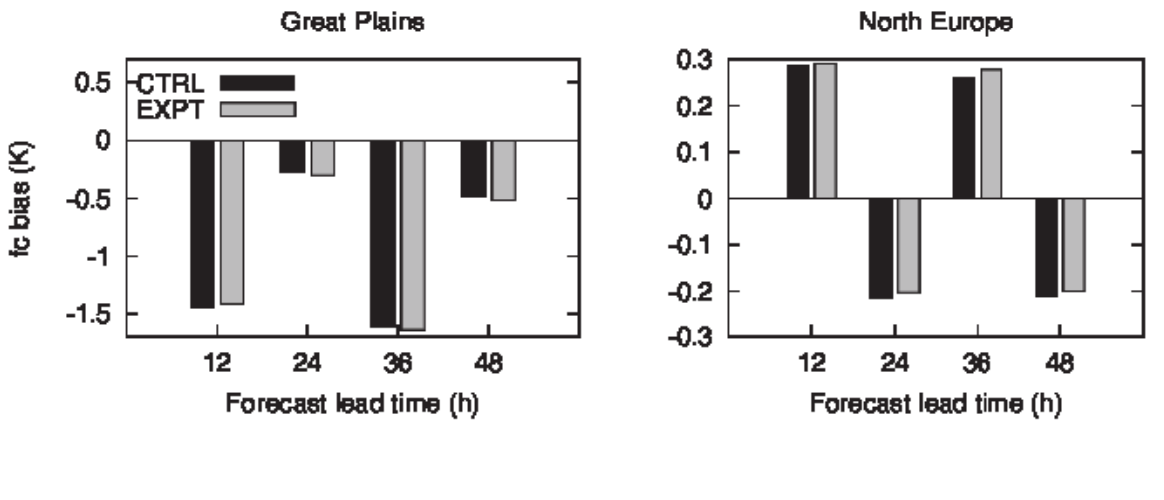
forecast against in-situ 2 m